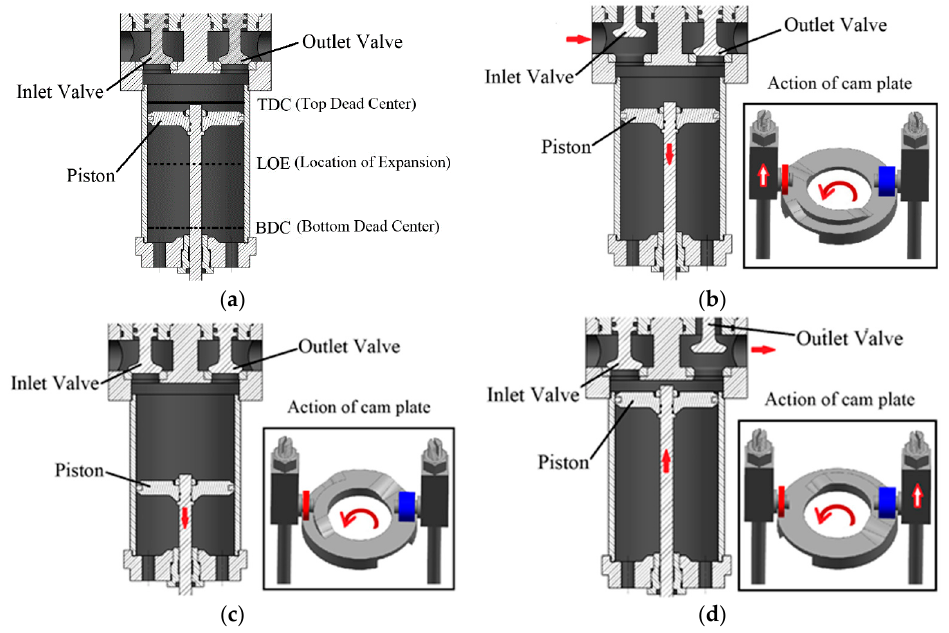
Figure 4. Working process of FPE and corresponding behaviors of the valve train: ( a ) initial position; ( b ) intake process; ( c ) expansion process; ( d ) exhaust process.